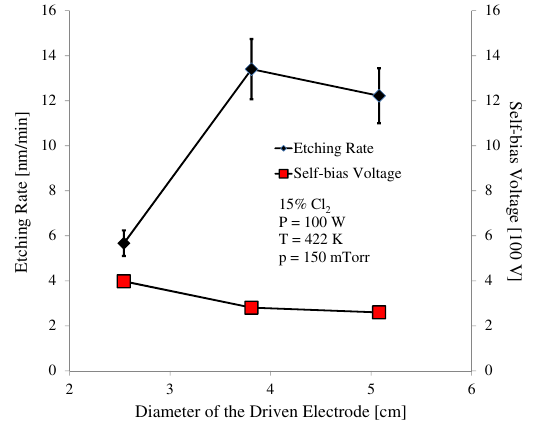
FIG. 7. Etching rate and self-bias dependence on the diameter of the driven electrode. Solid lines are visual guidelines.